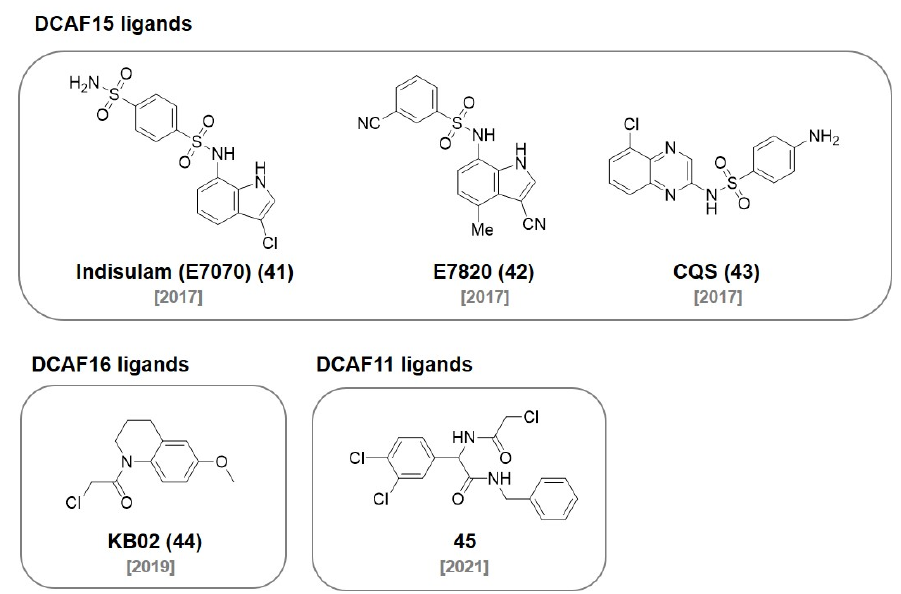
Figure 12. Chemical structures of recently reported DCAF ligands.